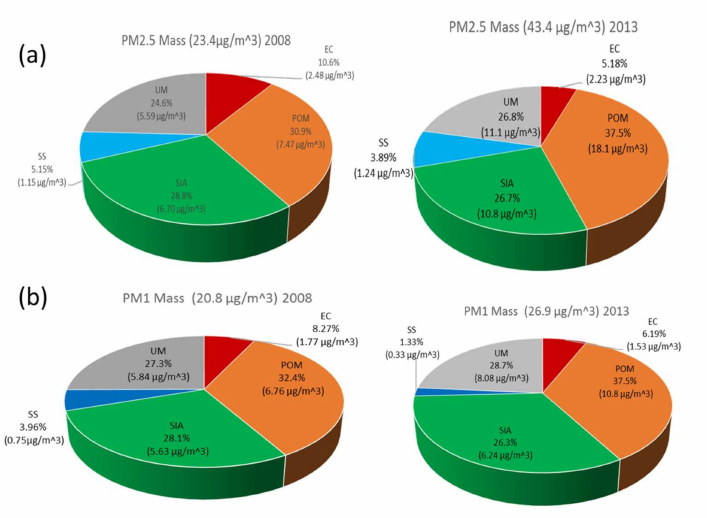
Figure 2. Di ff erentiation of ( a ) the PM 2.5 and ( b ) the PM 1 mass closure profile in March 2008 and